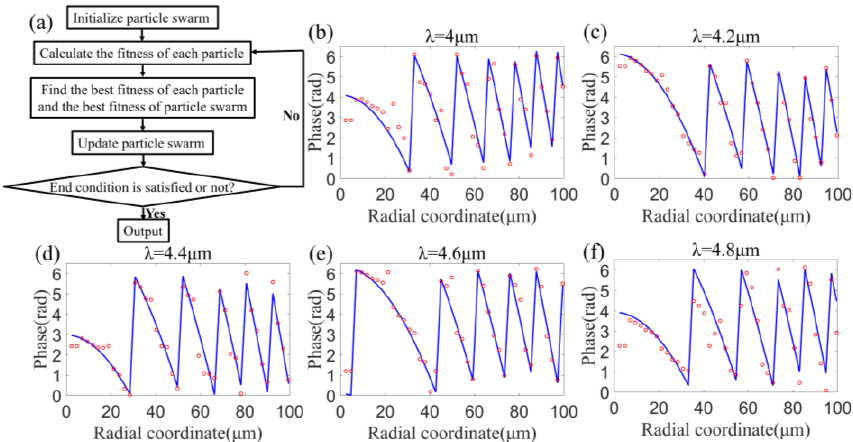
Figure 3. ( a ) Flowchart of PSO algorithm. ( b – f ) Comparisons between the corrected required phase profiles (blue line) and the phase profiles induced by the designed metalens (red point) at wavelengths of 4.0 μm ( b ), 4.2 μm ( c ), 4.4 μm ( d ), 4.6 μm ( e ) and 4.8 μm ( f ), as functions of the radial coordinate of the metalens.